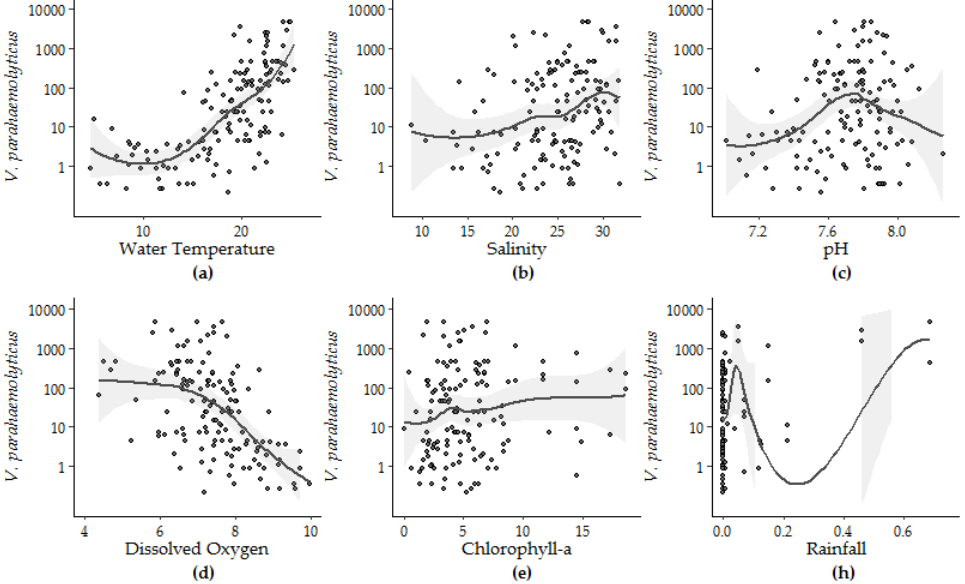
Figure 5. Loess smoothing applied to V. parahaemolyticus concentrations and ( a ) water temperature, ( b ) salinity, ( c ) pH, ( d ) DO—dissolved oxygen, ( e ) CHL—chlorophyll- a , and ( h ) rainfall.